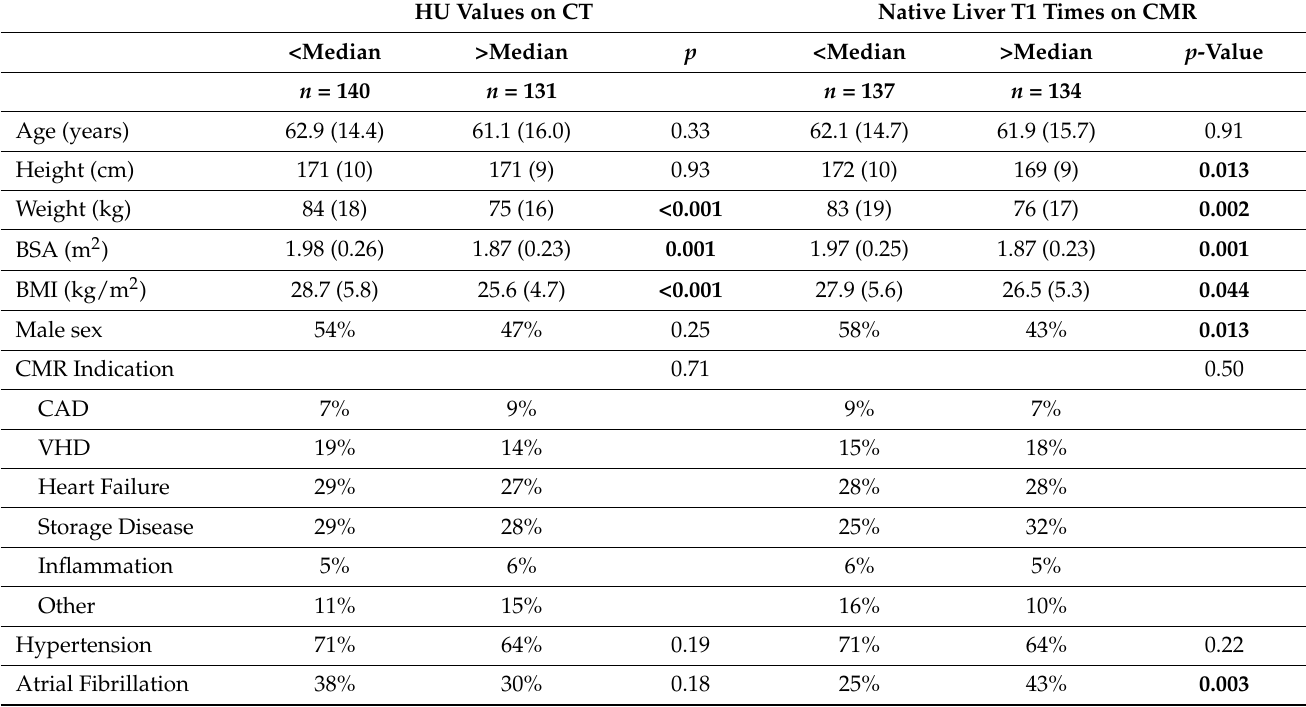
Table 1. Baseline characteristics, stratified by medians of liver HU values on computed tomography and native T1-times on cardiovascular magnetic resonance imaging.